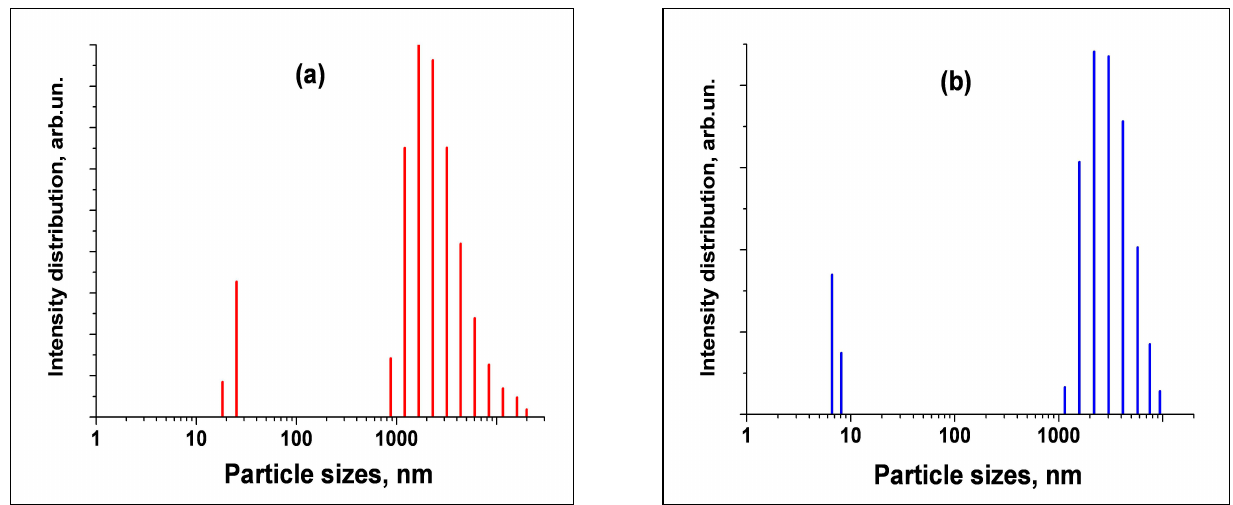
Figure 5. ( a ) Intensity distribution for sol prepared from Pt/C-1 (red). ( b ) Intensity distribution for sol prepared from Pt/C-2 (blue).